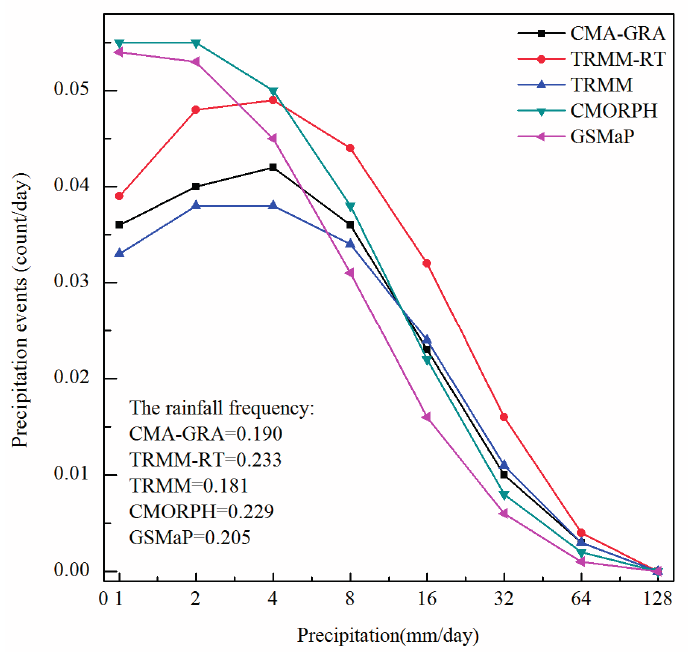
Figure 2. Intensity distribution of precipitation events calculated from four satellite based precipitation datasets and measurements